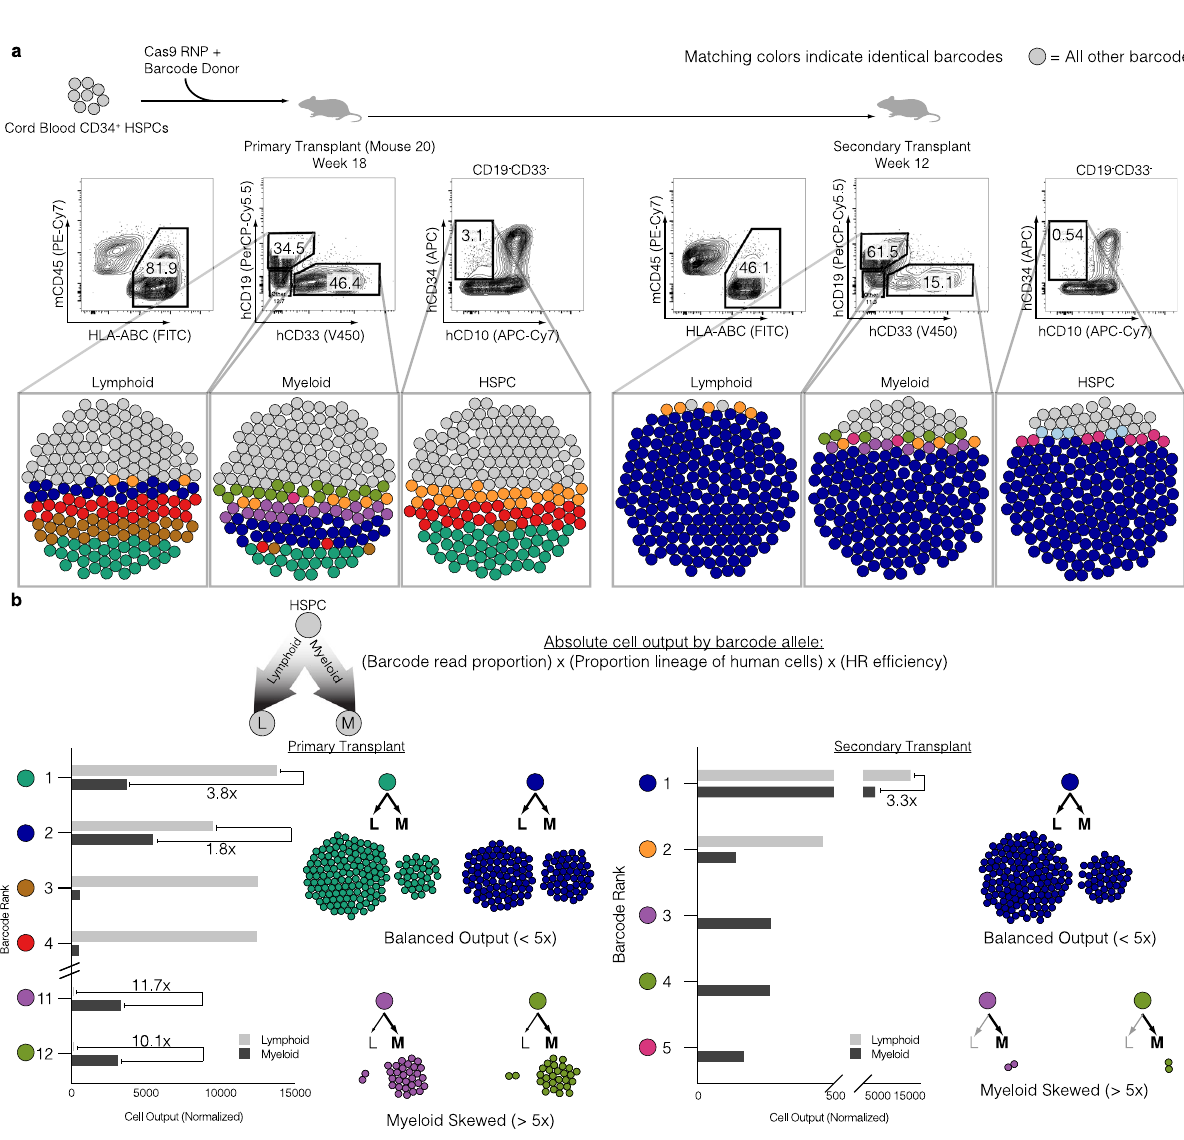
Fig. 4 Identi fi cation of clonal dynamics of HBB-targeted HSPCs. a Top: Experimental schematic. Middle: Flow cytometry plots representing robust bi- lineage engraftment in primary transplant (left, week 18 post-transplant) and secondary transplant (right, week 12 post-transplant). Bottom: Bubble plots representing barcode alleles as unique colors from each indicated sorted population. Shown are the three most abundant clones from all six populations. All other barcodes represented as gray bubbles. b Normalized output of barcode alleles with respect to lineage contribution. Total cell output (bar graphs) from indicated barcodes adjusted for both differential lineage output and genome editing ef fi ciency within each subset. Examples of various lineage skewing depicted, with cell counts proportional to the absolute contribution to the xenograft. Skewed output de fi ned as 5-fold or greater bias in absolute cell counts towards lymphoid or myeloid